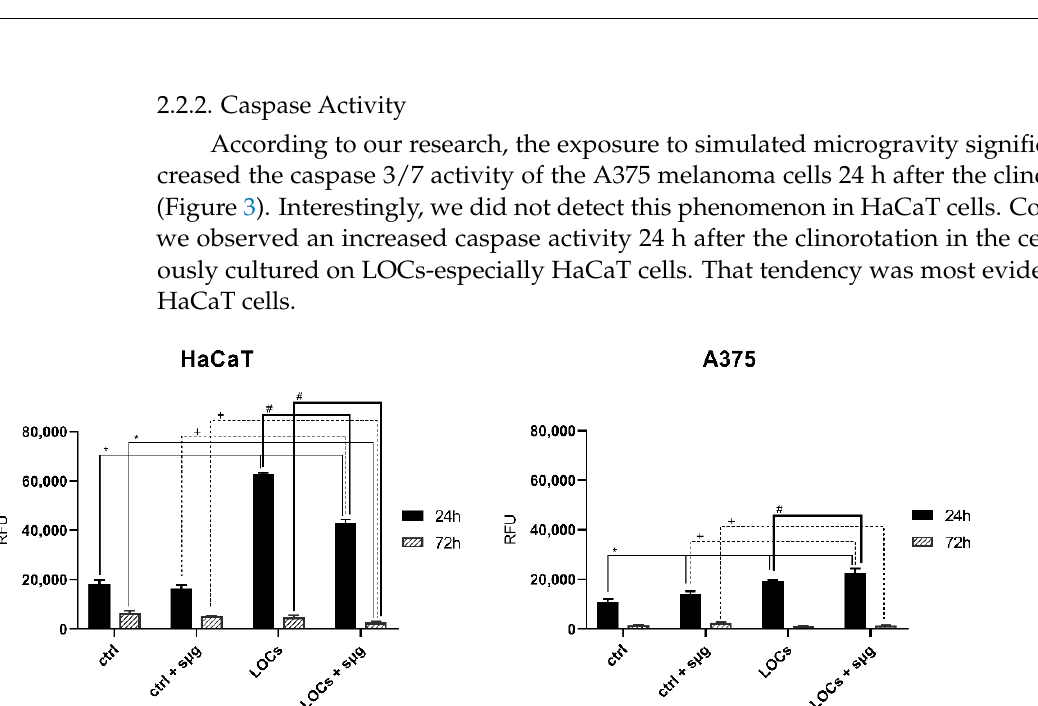
Figure 2. Evaluation of HaCaT and A375 cells viability ( A ) and mitochondrial activity ( B ) after the exposure to simulated microgravity. Statistically significant differences in comparison to ctrl cells: *, ctrl + sµg cells: +, and LOC cells: # ( p ≤ 0.05).